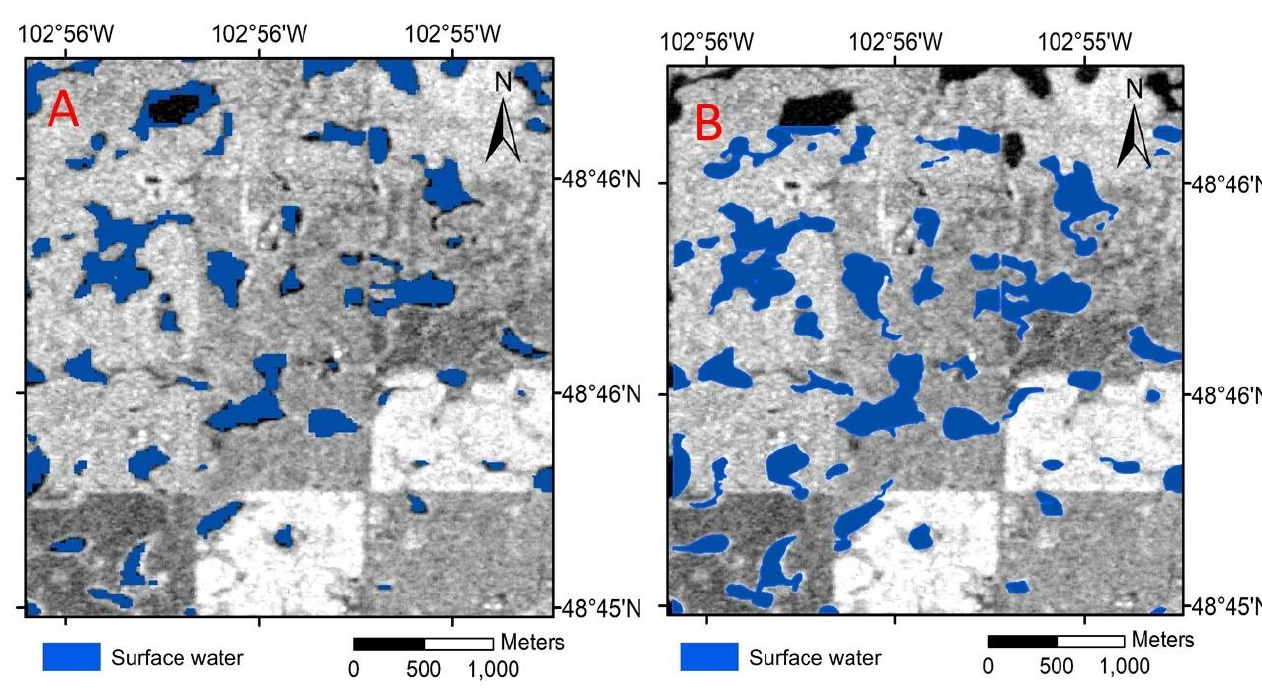
Figure 8. Visual comparison of wetland inundation maps between predicted ( A ) and observed wetlands in aerial surveys ( B ) in a portion of the study area. The accuracy assessment for small vegetated wetlands and small non-vegetated wetlands are presented in Tables 6 and 7, respectively. Table 6. Accuracy assessment for detection of wetland surface water (WSW) vs. other classes (OC) in wetlands that are both small (<850 m 2 ) and highly vegetated wetlands (vegetation > 40%) from the year 2016 on the test data subset that was withheld from model calibration.